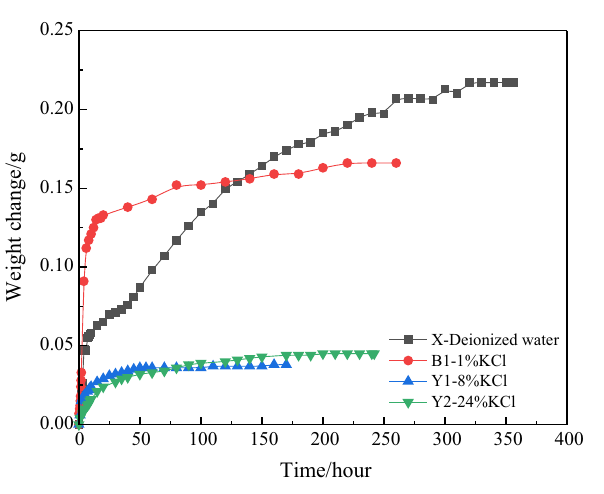
Fig. 13 SI of brine with different salinities, S